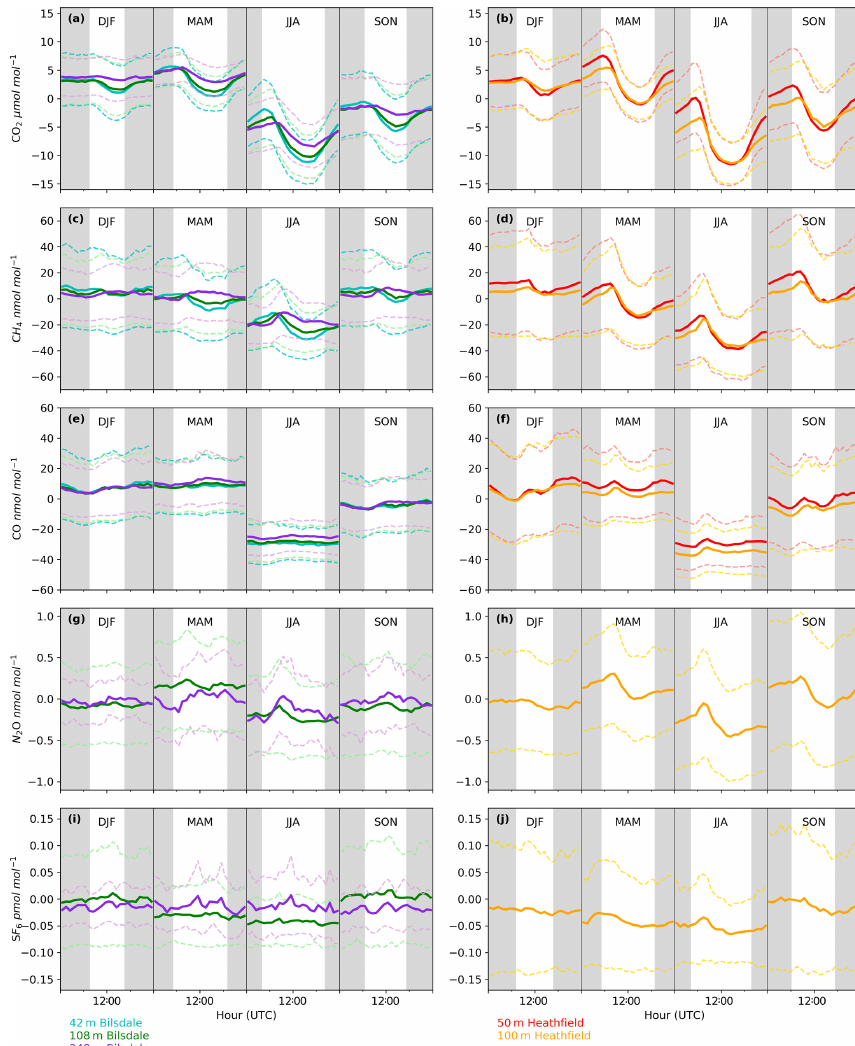
Figure 6. Mean diurnal cycle by season of detrended hourly mean values for (a, b) CO 2 , (c, d) CH 4 , (e, f) CO, (g, h) N 2 O and (i, j) SF 6 of the Bilsdale 42m (blue), 108m (green) and 248m (purple) and Heathfield 50m (red) and 100m (yellow) intake heights. Dashed lines are the standard